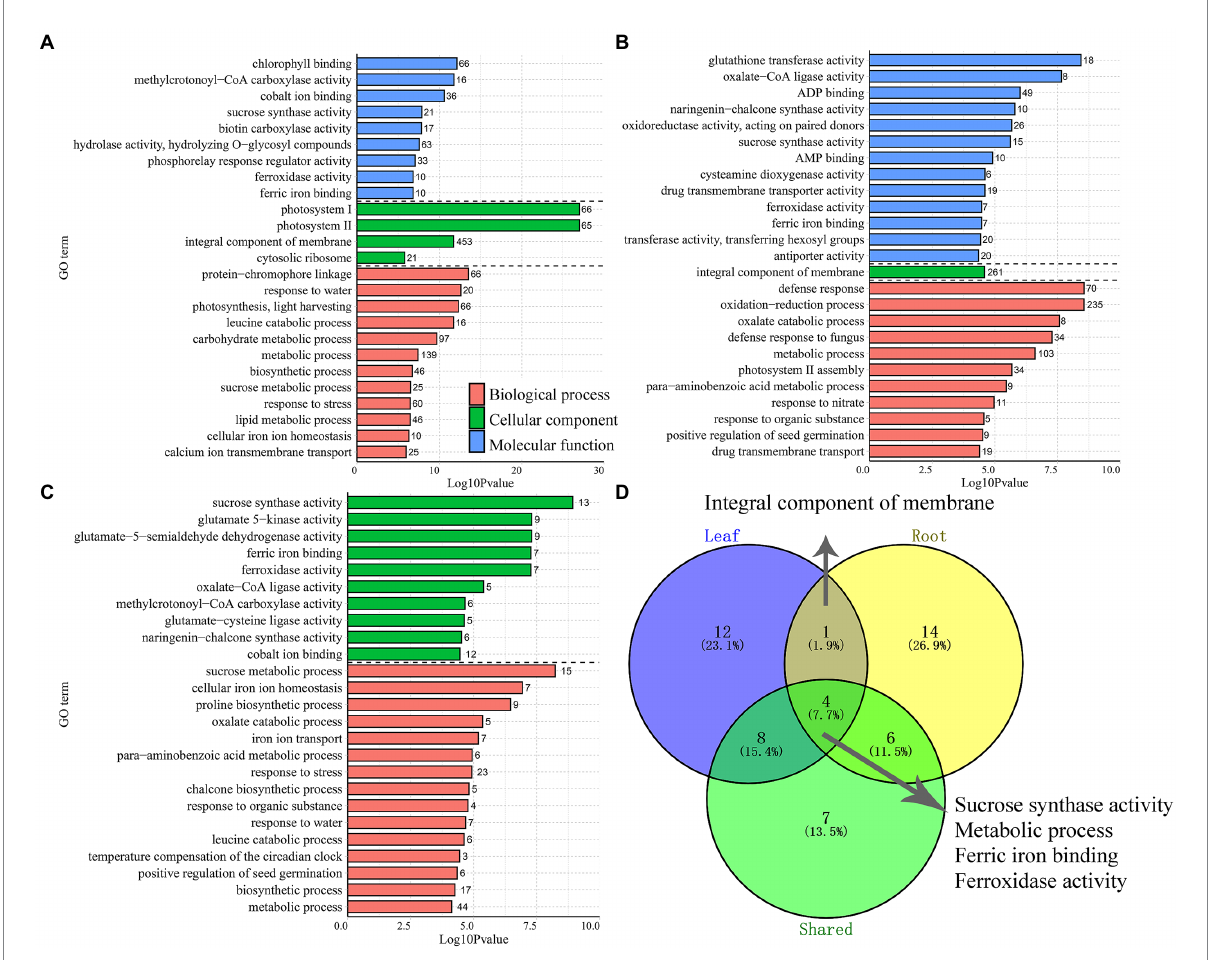
FIGURE 4 The distribution of the top 25 most represented GO categories. The DEGs obtained from leaves (A) , roots (B) , and shared between two tissues (C) were assigned to three main categories: biological process, cellular component, and molecular function. The number of enriched GO categories distribution (D)